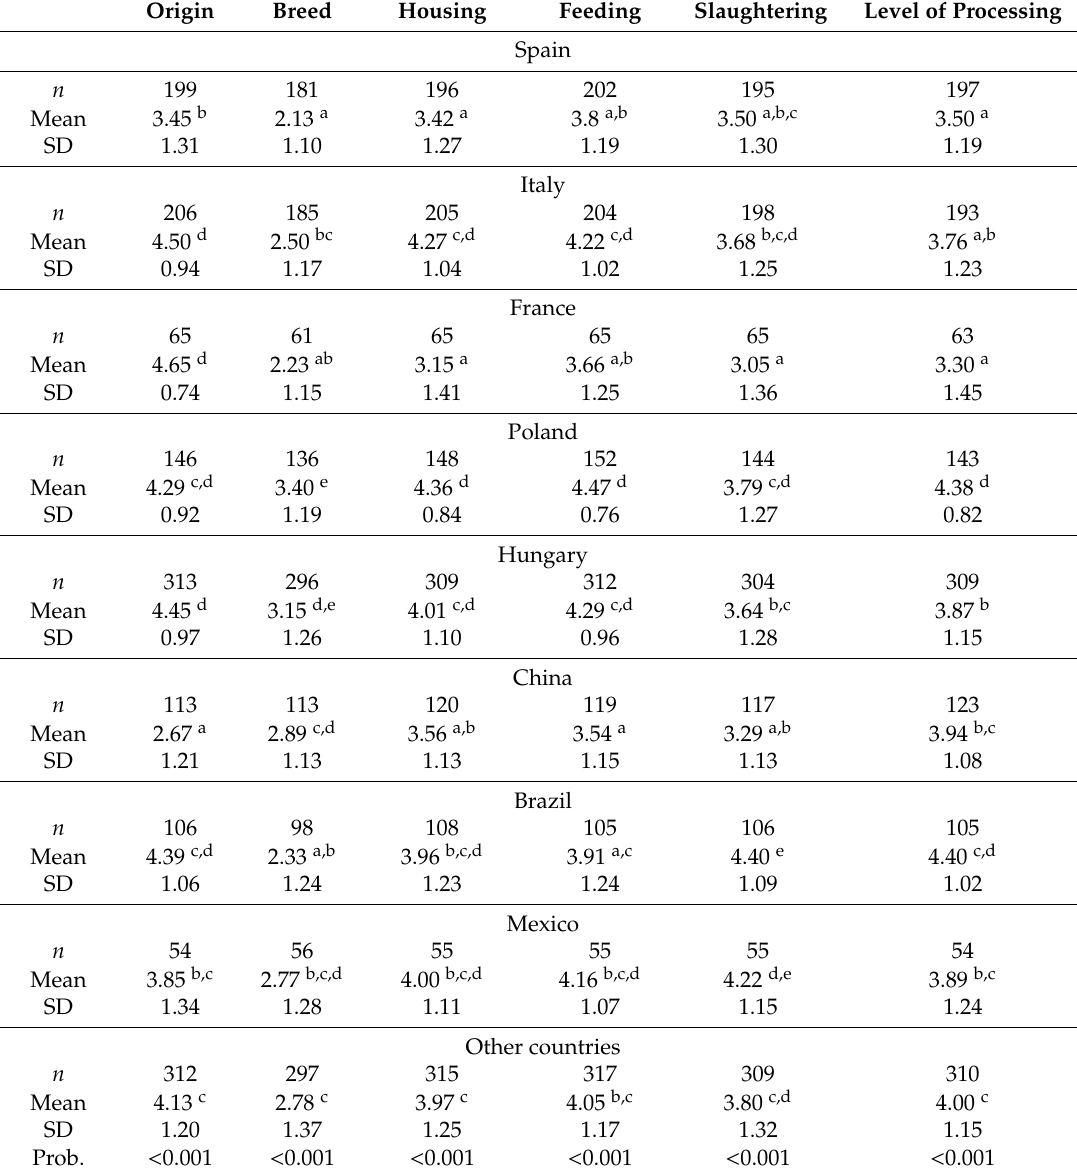
Table 3. E ff ect of the production method and slaughtering method and processing on purchase decision depending on the countries (on 1–5 scale). Origin Breed Housing Feeding Slaughtering Level of Processing